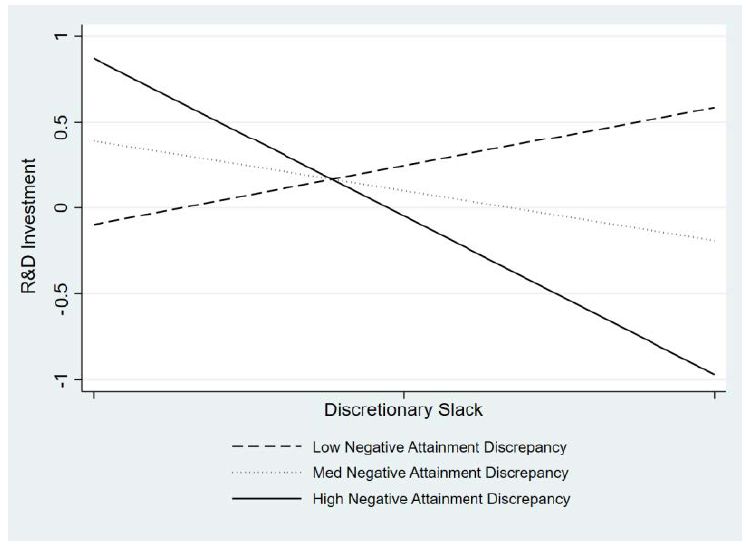
Figure 2. Effects of discretionary slack on R&D investment at different levels of negative attainment discrepancy.